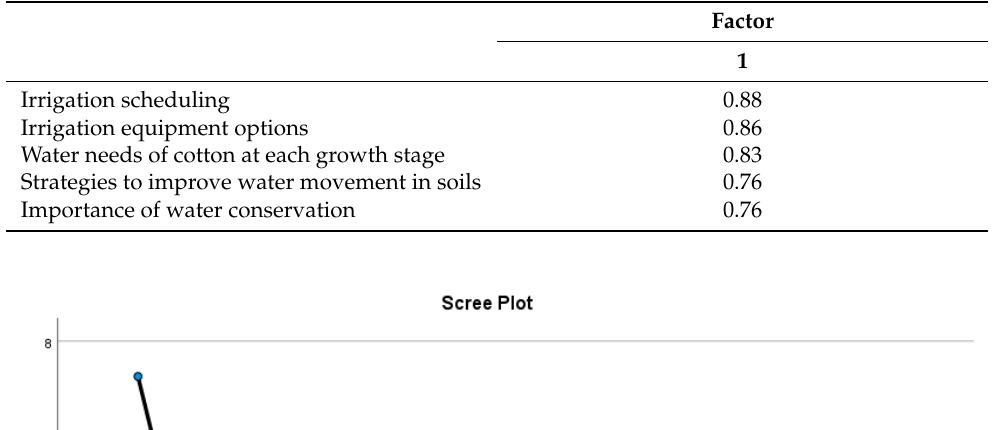
Table 12. Factor loading and importance items of water management and conservation competencies.